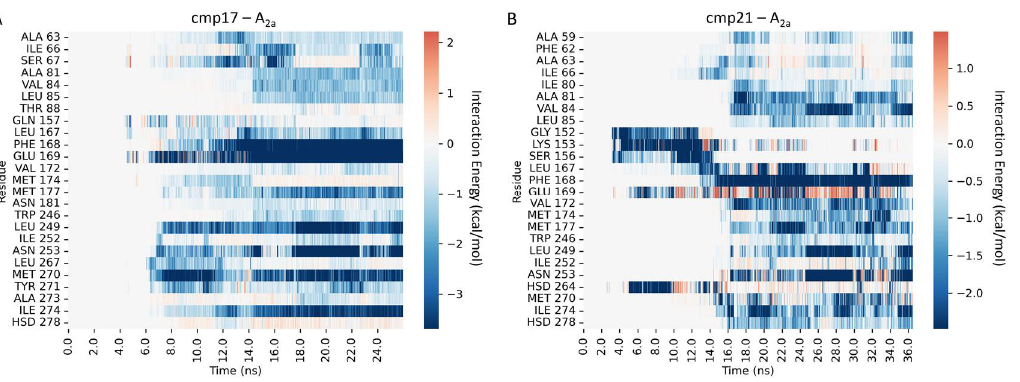
Figure 9. Per-residue decomposition of the protein–ligand interaction energy descriptive of the recognition process between A 2A AR and either the “dual anta-inhibitor” (compound 17 ) ( A ) or compound 21 ( B ) sampled with Supervised Molecular Dynamics (SuMD) simulations.